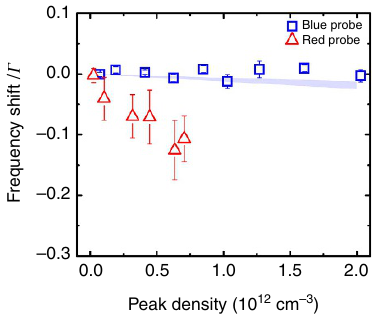
Figure 4 | Frequency shift. Comparison of frequency shift normalized to the corresponding natural linewidth for the blue and red transitions. The blue frequency shift is consistent with 0–0.004 of G at an atomic density of 10 12 cm (cid:2) 3 . The red shift, on the other hand, shows more than 0.1 G at densities up to 0.7 (cid:3) 10 12 cm (cid:2) 3